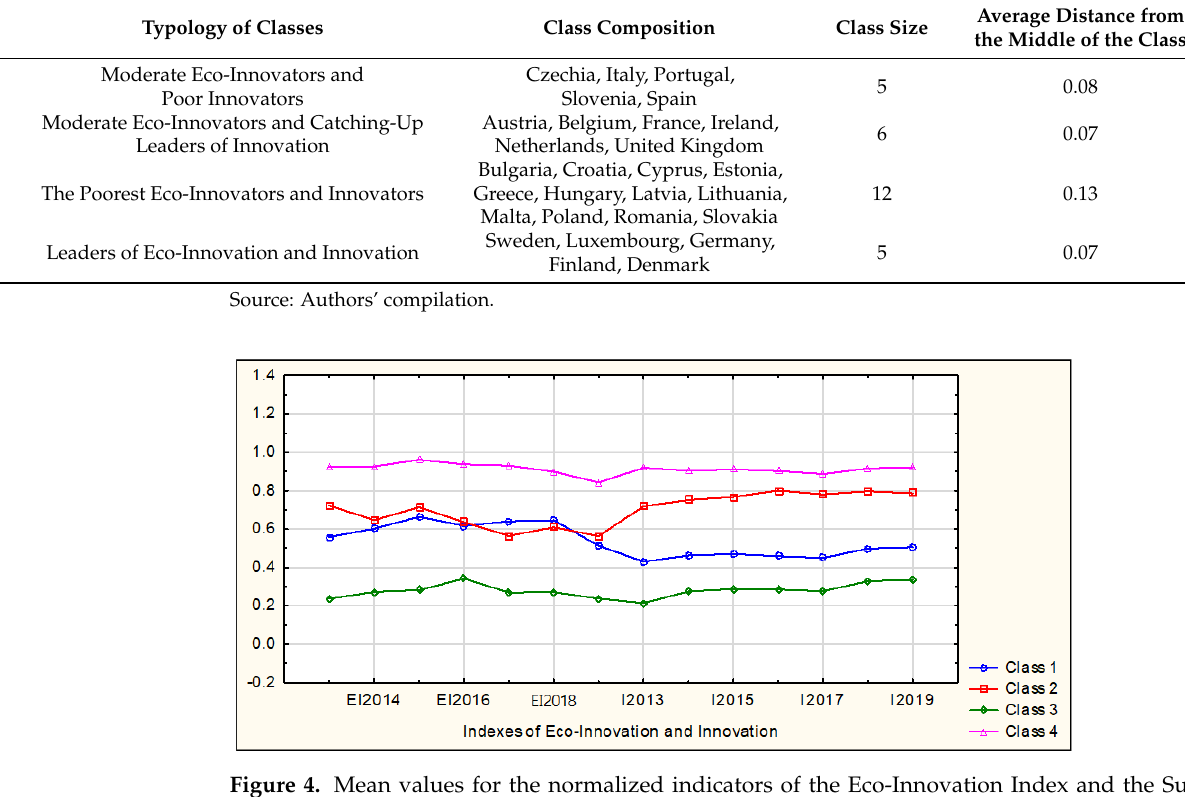
Figure 4. Mean values for the normalized indicators of the Eco-Innovation Index and the Summary Innovation Index of the EU countries in the years 2013–2019. Source: authors’ compilation based on